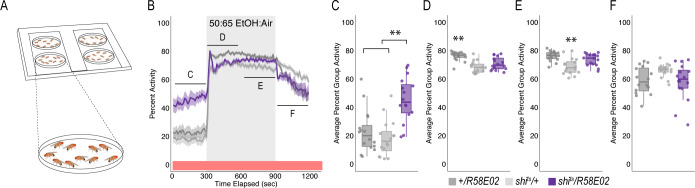
Although inactivation of PAM neurons increased group flies in an open field arena (n = 15), it did not affect alcohol induced activity suggesting that a decrease in preference is encoded independently from the amount of activity animals exhibit while intoxicated (Figure 1G).(A) Schematic of flyGrAM. Groups of ten male flies were placed into four behavioral chambers. Flies were exposed to five minutes of air, following by ten minutes of ethanol, and lastly 5 min of air. Group activity of flies was recorded at 33 frames per second. (B) Group activity counts were binned over 10 s periods, averaged across biological replicates of 10 flies each (n = 15) and plotted against time. Ethanol was delivered over a 10 min period starting at 300 s as denoted by the gray shaded region. Lines depict mean +/- standard error. Repeated Measures ANOVA with planned contrasts at baseline, early ethanol, late ethanol, and recovery indicated a significant interaction between groups and treatment (F(3.38, 76)=16.21, p=0.00). Mauchly’s test indicated that the assumption of sphericity had been violated (X2(5)=90.51, p=0.00), therefore multivariate tests are reported (ε=0.563). All Posthoc analyses were performed with Bonferroni corrections. (C) Group activity responses of shits/R58E02 were significantly higher during baseline as compared to genetic controls (p=0.000) (D) Group activity responses of shits/R58E02 during early ethanol (first 5 min) was not significantly different from both genetic controls. (E) Group activity responses of shits/R58E02 during late ethanol (last 5 min) was not significantly different from both genetic controls (F). Group activity responses of shits/R58E02 during recovery were not significantly different for genetic controls *p<0.05, **p<0.01.